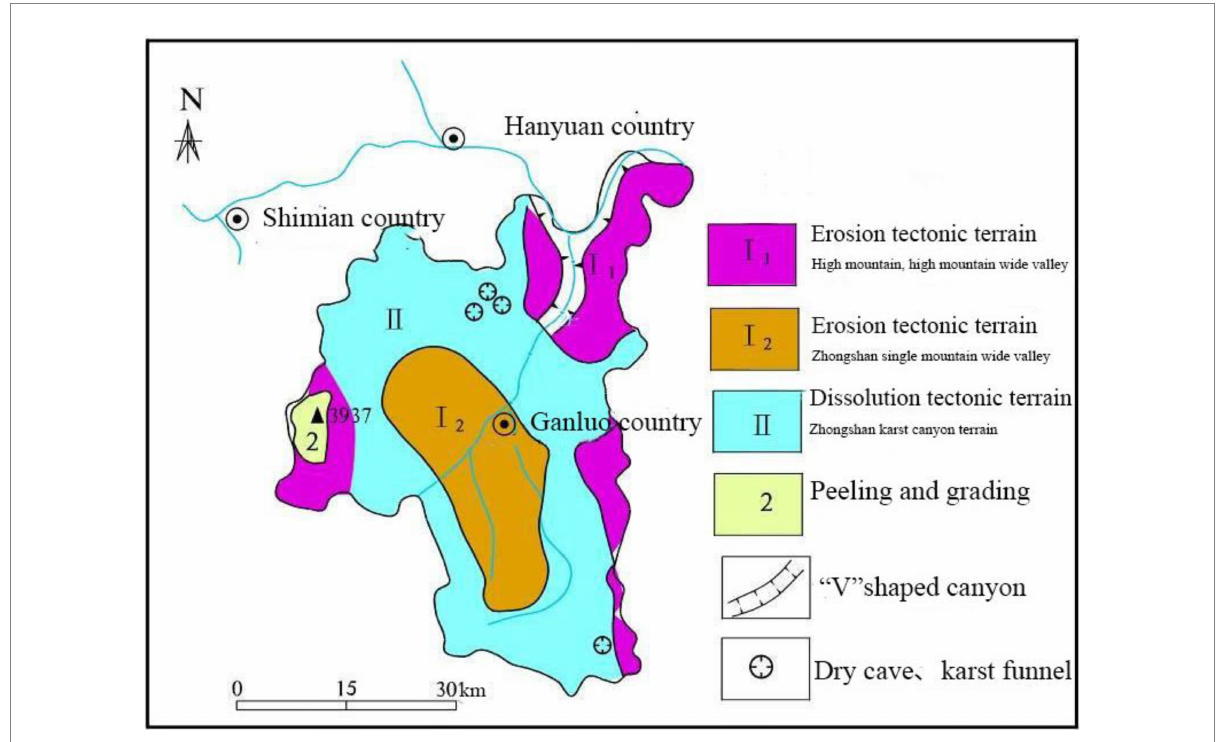
FIGURE 1 Geomorphological map of Ganluo